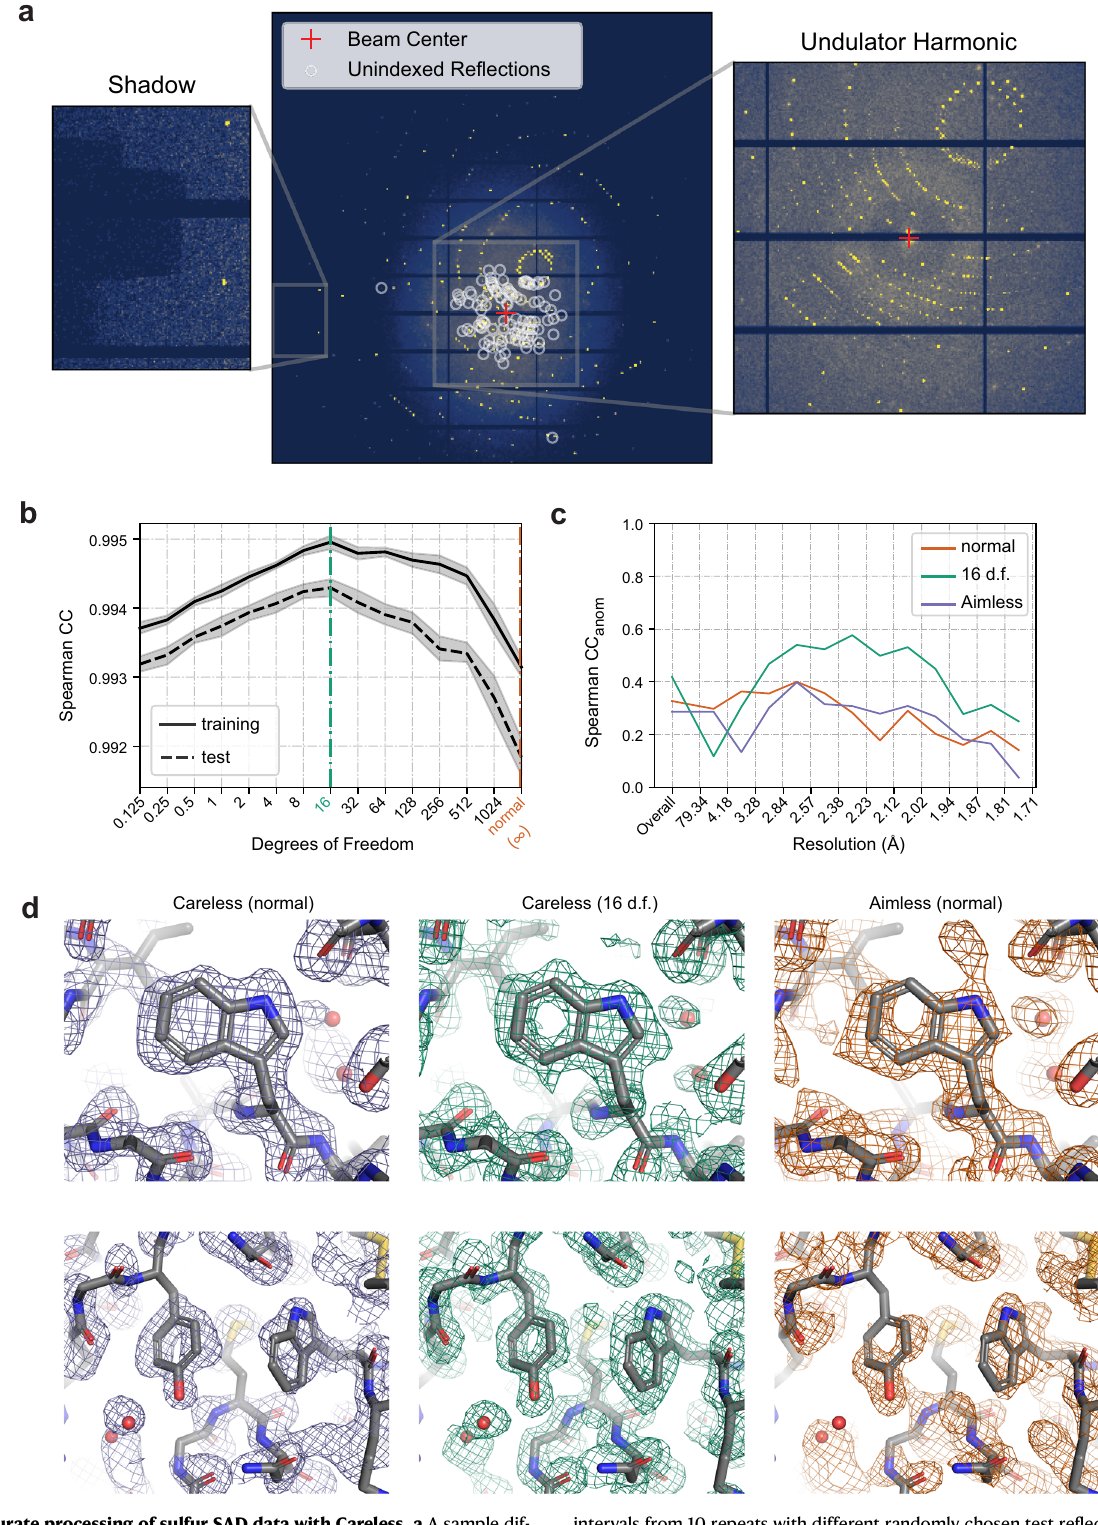
intervals from 10 repeats with different randomly chosen test re fl